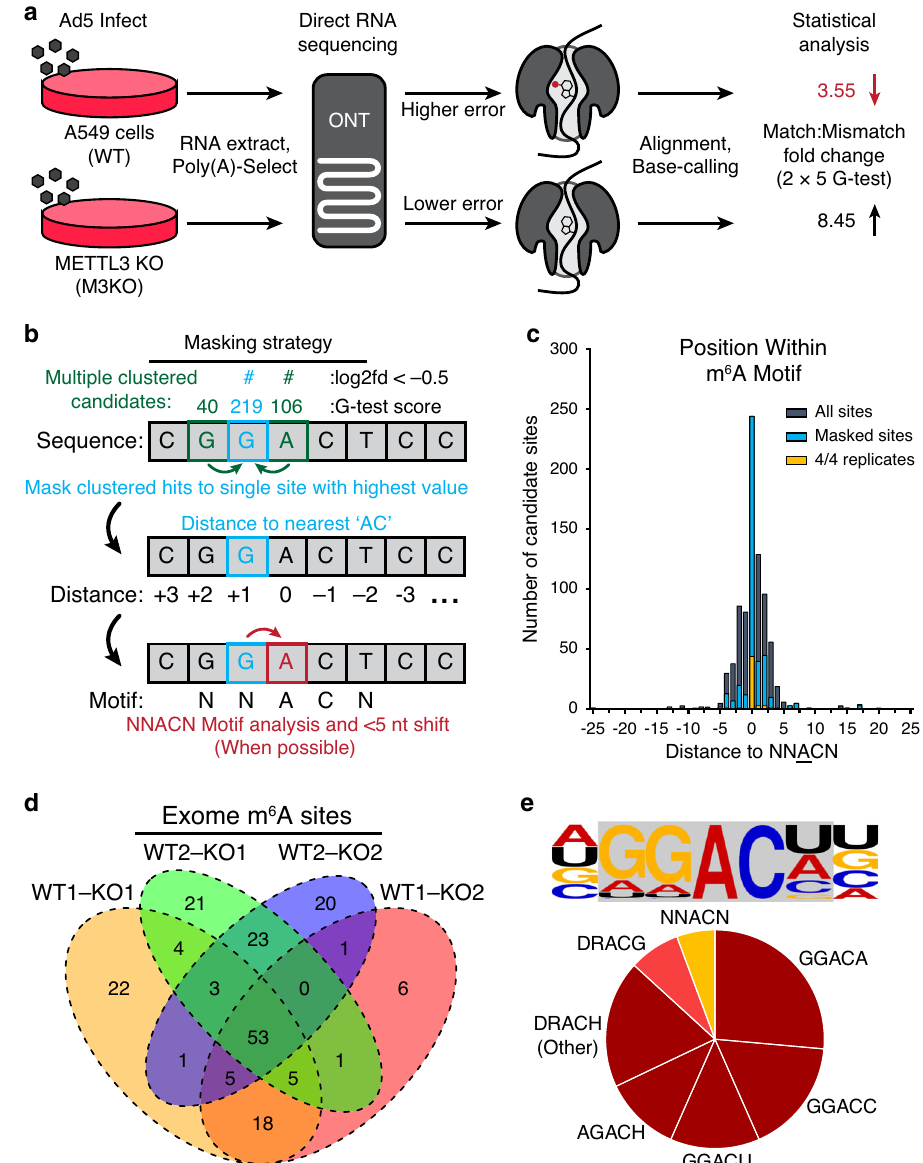
Fig. 3 A statistical framework for m 6 A detection using direct RNA sequencing. a Schematic diagram of proposed strategy to detect m 6 A sites using direct RNA sequencing. RNAs generated in WT cells (METTL3 positive) will contain m 6 A modi fi cations, while RNA from METTL3 KO cells (M3KO) will not. As modi fi ed RNA passes through the pore there will be a higher error rate during base-calling compared to unmodi fi ed RNA. When compared to the reference transcriptome, the aggregate fold change in the Match:Mismatch ratio will be lower in at nucleotides containing m 6 A. b Proposed strategy for masking neighboring candidates. Here, three sites within fi ve nucleotides of an AC produce signi fi cant G-test scores. All candidates are collapsed to the single candidate within fi ve nucleotides giving the highest G-test statistic. Collapsed/masked candidates are analyzed for their distance to nearest ‘ AC ’ dinucleotide. When nearest ‘ AC ’ dinucleotide is within the fi ve-nucleotide window (dictated by nanopore size) the candidate is shifted to the closest ‘ A ’ within an ‘ AC ’ core, if possible. c For each signi fi cant candidate site with a one-fold or greater difference in the match:mismatch ratio, the distance to the nearest AC motif was calculated and plotted (gray). This was repeated after masking neighboring candidates (blue) and for the 53 genome-level sites identi fi ed across all four comparisons (gold). d Comparisons between WT and M3KO (KO) datasets yields 184 putative m 6 A modi fi ed bases (post- collapse) of which 53 are consistently detected across all four comparisons. e The consensus fi ve-nucleotide motif for putative m 6 A modi fi ed bases in the Ad5 transcriptome is predominantly comprised of four common DRACH distinct transcripts while supplementary alignments indicate level analysis. Here, we aligned our nanopore sequencing reads potentially chimeric reads where two segments of the same read against 75 distinct transcripts derived from the recently re- align to separate overlapping transcripts (Fig. 4a). Given the annotated adenovirus Ad5 genome 63 and observed that the possibility that overlapping transcript isoforms may share the aligner (MiniMap2 64 ) produced secondary alignments for many reads and supplementary alignments for a smaller subset of reads same DRACN motifs but still undergo differential methylation, (Fig. S2a). Secondary alignments indicate that a region of a given we reasoned that reads with multiple alignments could reduce sequence read aligns with high con fi dence against two or more sensitivity of detection. We thus retained only reads that